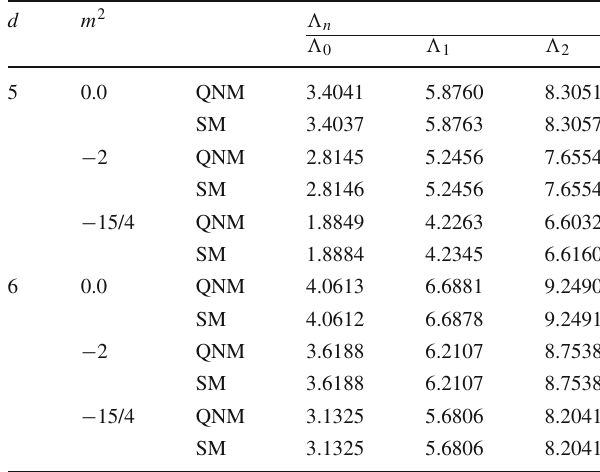
Table 2 First three lowest (cid:2) n ’s for Einstein gravity via quasinormal modes (QNM) and shooting method